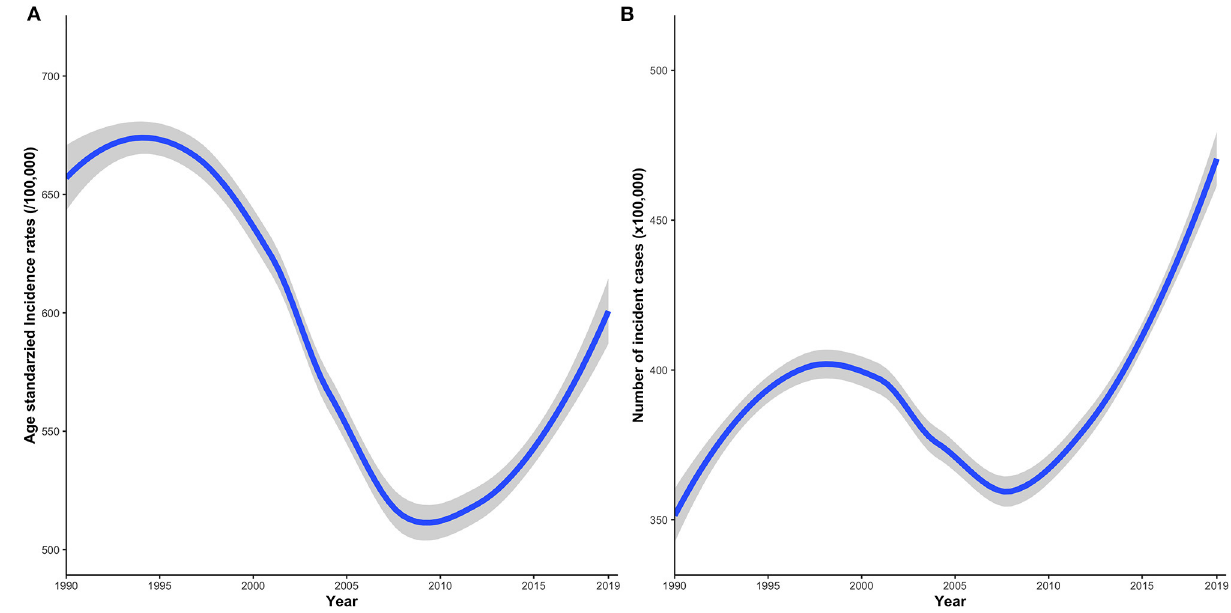
Frontiers in Public Health |